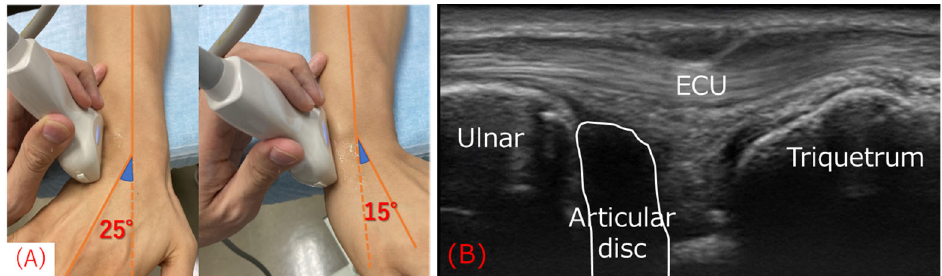
Figure 1. Ultrasonography (US) procedure and image in the long ‐ axis view. ( A ) A US transducer was placed on the dorsal ulnar side of the wrist. Participants actively moved their wrists from 15º of radial deviation to 25º of ulnar deviation. ( B ) US image of the extensor carpi ulnaris (ECU) tendon at the triangular fibrocartilage complex level acquired by the procedure shown in ( A ). The ulnar styloid process was below the ECU tendon on the left side and the triquetrum on the right